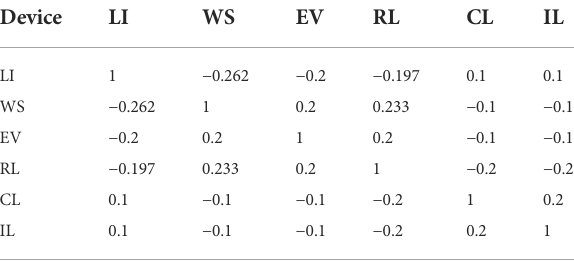
TABLE 3 Correlation coef fi cient between DGs and load. Device